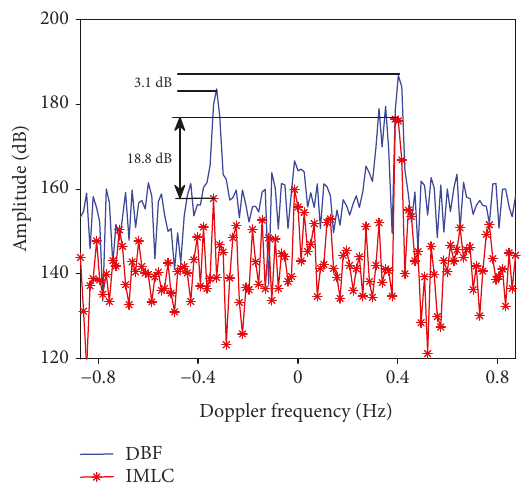
Figure 21: Suppression result for the noncooperative